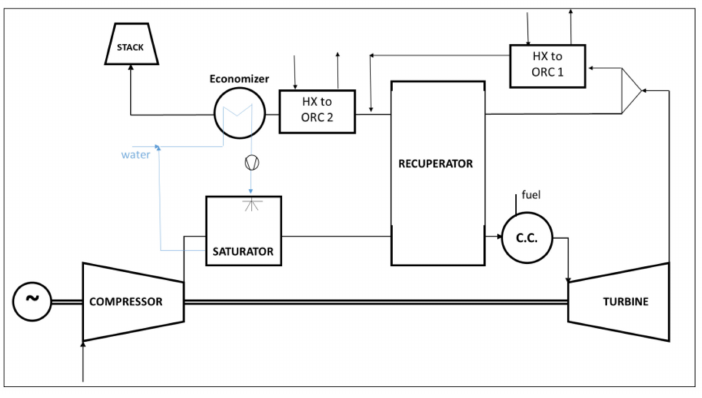
Figure 10. Integrated layout with mHAT and two ORCs